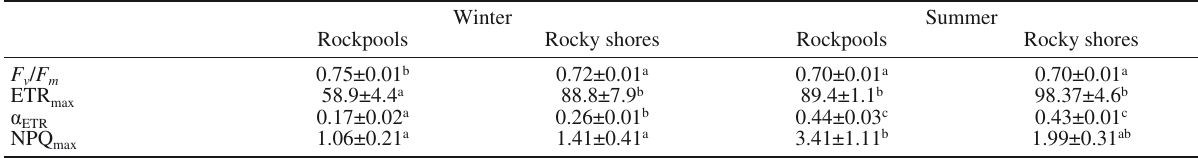
Table 1. – Maximum quantum yield ( F / F ), electron transport rate (ETR ) expressed as μmol electrons m –2 s –1 , photosynthetic efficiency v m max ( α ) as the initial slope of ETR versus irradiance rapid light curves (RLCs) and maximum non-photochemical quenching (NPQ ETR (February) and summer (July) C. tamariscifolia collected from rockpools and rocky shores (field algae). Data are expressed as mean±standard deviation of n=6. Different letters indicate significant differences between period of times or collection microhabitat for each variable.